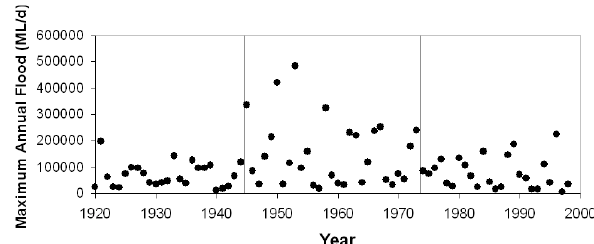
Figure 1. Annual maximum timeseries for a northern NSW catchment. IPO/PDO phase changes indicated by vertical lines.